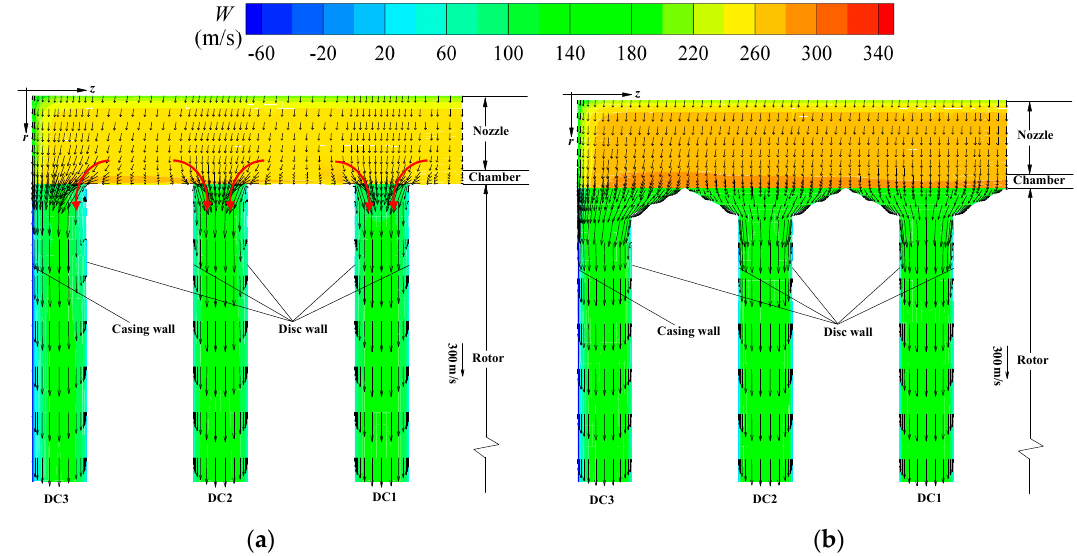
Figure 14. Vectors and relative tangential velocity distributions on the radial-cross section of 0 ° for the one-to-many turbines. ( a ) OTM-B; ( b ) OTM-T-2.